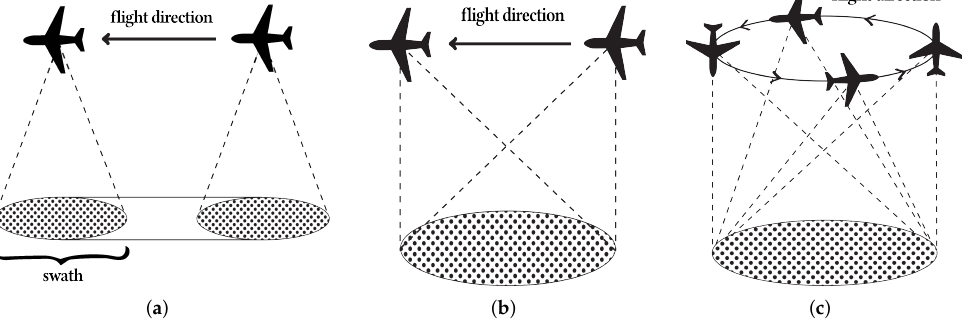
Figure 3. Illustration of the different operating SAR modes: Stripmap, Spotlight, and Circular SAR. ( a ) Stripmap SAR, where the platform movement allows for a larger ground cover, as the swath moves along with it. The resolution is lower than other SAR modes, however, the covered area is larger. ( b ) Spotlight SAR, where the antenna moves along with the platform, illuminating the same region at every instance of time, allowing for higher resolution images. ( c ) Circular SAR, where the platform moves in a circular motion, illuminating the same region at every instance of time, allowing for higher resolution of images due to the multiangular data